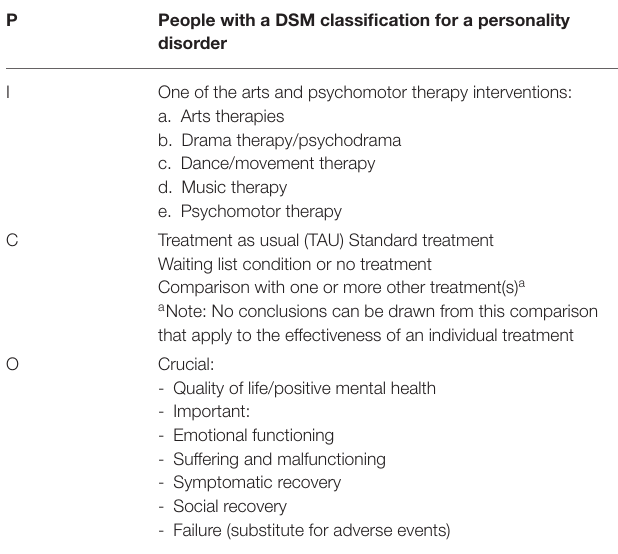
TABLE 2 | PICO for search. People with a DSM classification for a personality disorder One of the arts and psychomotor therapy interventions: a. Arts therapies